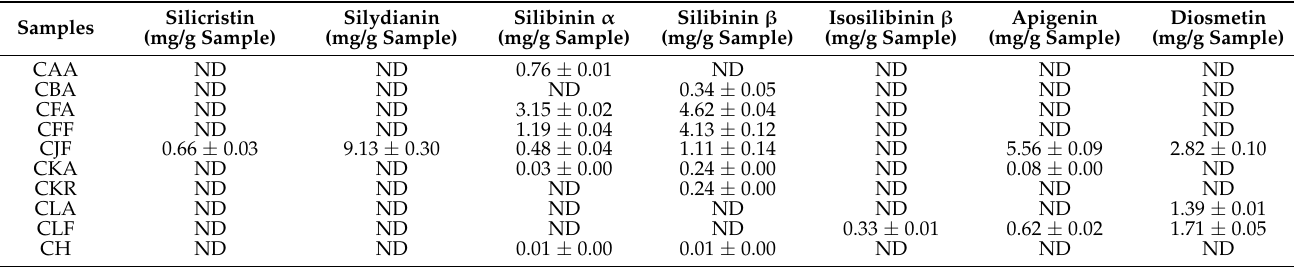
Table 4. The contents of major ingredients in Cirsium species in